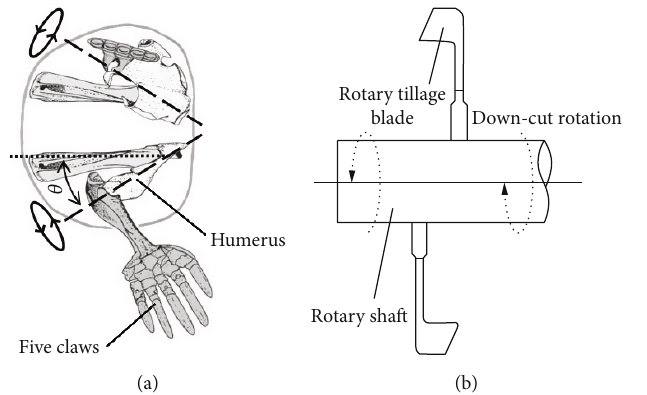
Figure 1: (a) Motion diagram of the mole claws according to Scott and Richardson [16]. (b) Motion diagram of the rotary tillage